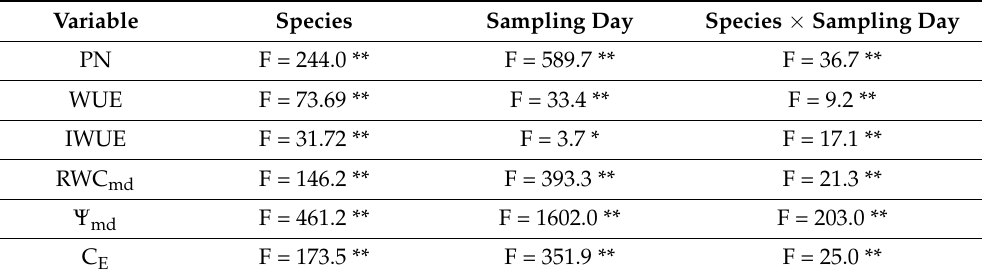
Table 1. F values from two-way ANOVA carried out to test the effect of the water stress of species, sampling day, and their interaction (species × sampling day) on net photosynthetic rate (P N ), water use efficiency (WUE), intrinsic water use efficiency (IWUE), relative water content (RWC md ), leaf water potential ( Ψ md ), and apparent carboxylation efficiency (C E ). ** p ≤ 0.001; * p ≤ 0.05.